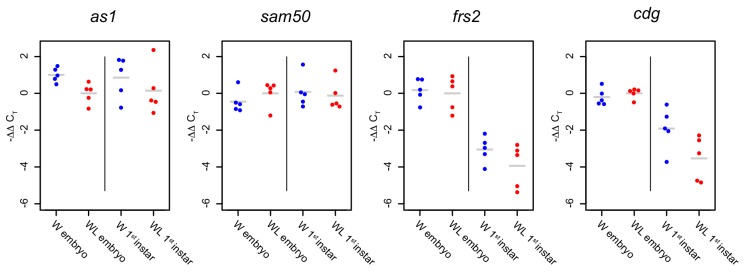
Genes in the insertion-adjacent region are not differentially expressed as measured by RT-qPCR analysis.Each gene was measured in five biological replicates collected from winged and wingless male embryos and first instar nymphs. Each point represents a replicate. Blue indicates winged and red indicates wingless males. Y-axes show the ΔCT values for each sample subtracted from the average ΔCT value of wingless embryos (-ΔΔCT): higher values therefore represent stronger relative gene expression. Short gray horizontal lines show means.